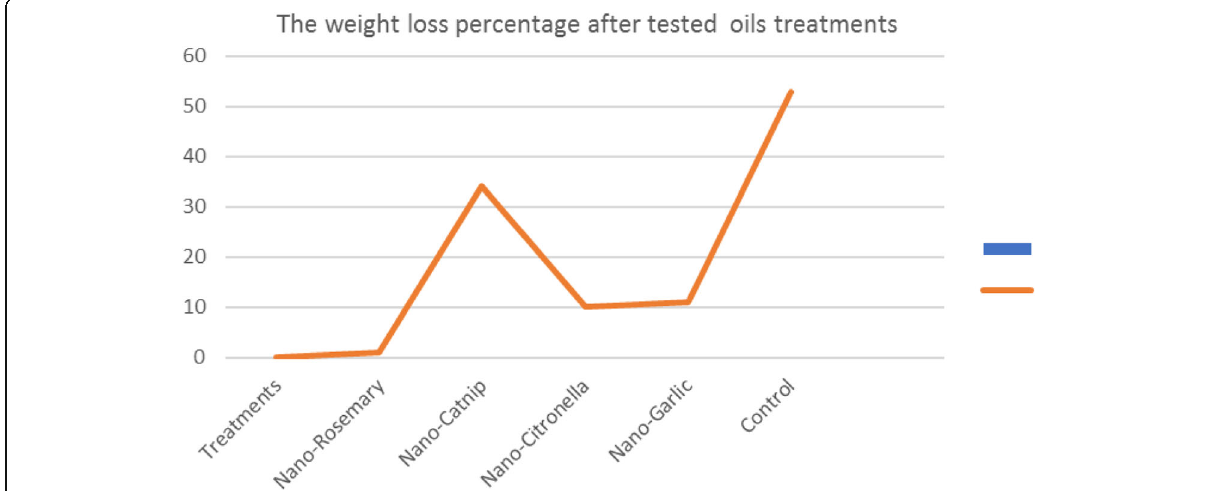
Fig. 1 Effect of tested oils on broad beans weight